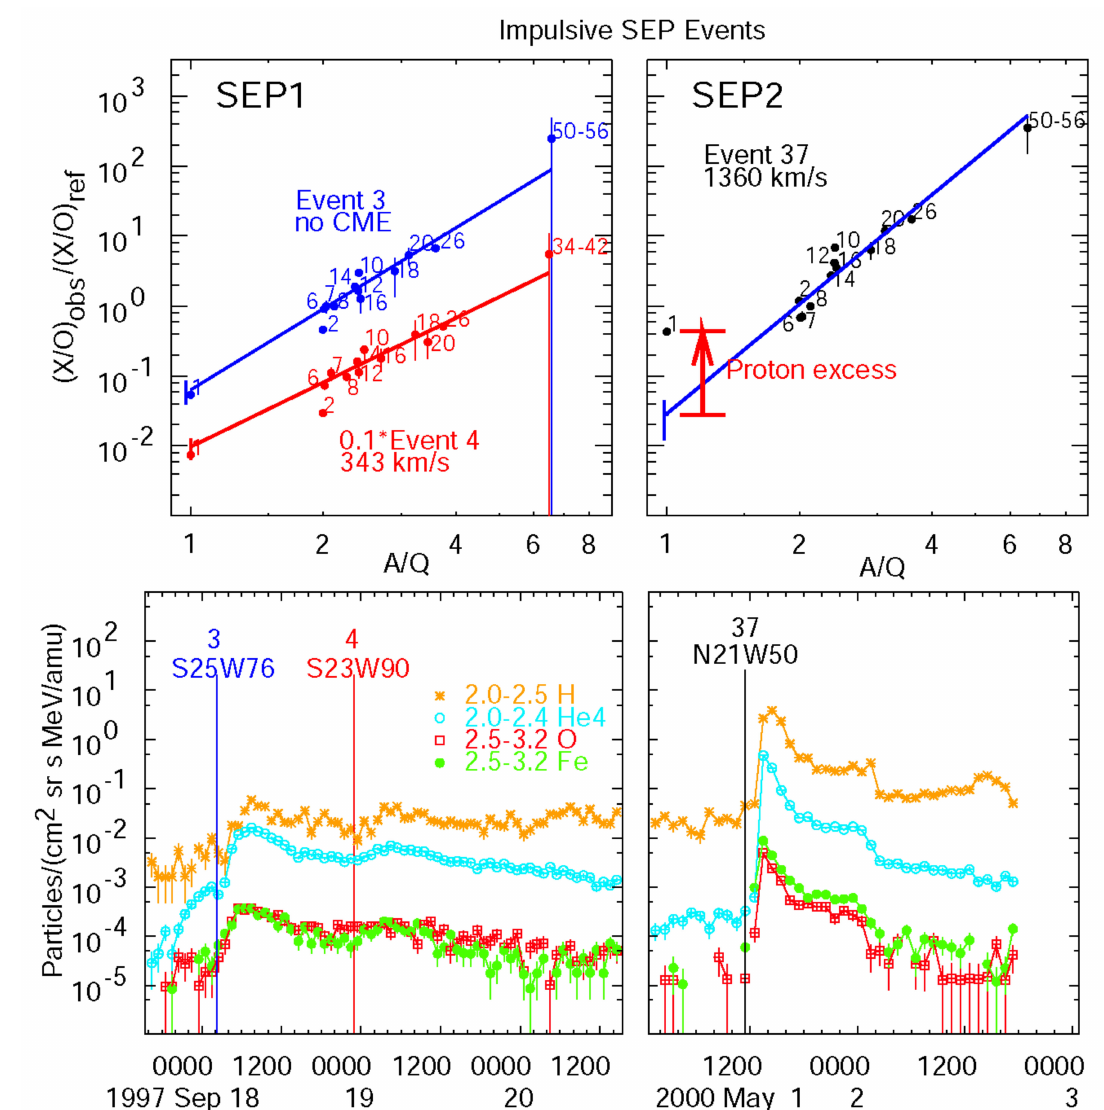
Figure 3. The lower panels show time histories of H, 4 He, O and Fe, at the indicated MeV amu − 1 , for three impulsive SEP events, two small SEP1 events on the left and a larger SEP2 event on the right. Event numbers shown above source coordinates refer to the event list [26]. Power-law fits to the abundance enhancements, noted by Z , in each event, are shown in the upper panels and CME speeds are listed when CMEs are seen. The right-hand Event 37 is an SEP2 class event because of its large proton excess noted. For the SEP1 events on the left, the protons abundances lie on the extrapolated power-law fits